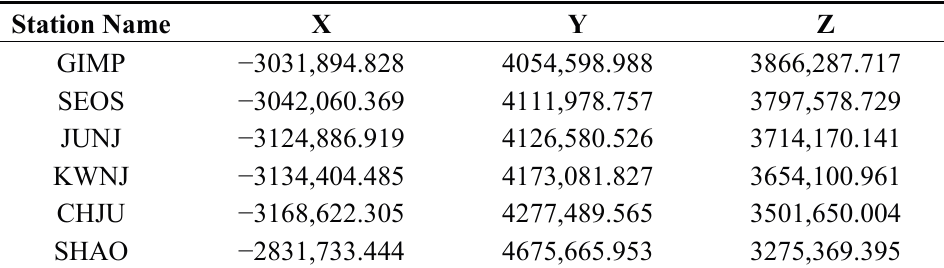
Table 1. ITRF2000 Cartesian coordinates for continuously operating reference station (CORS) (unit: m).